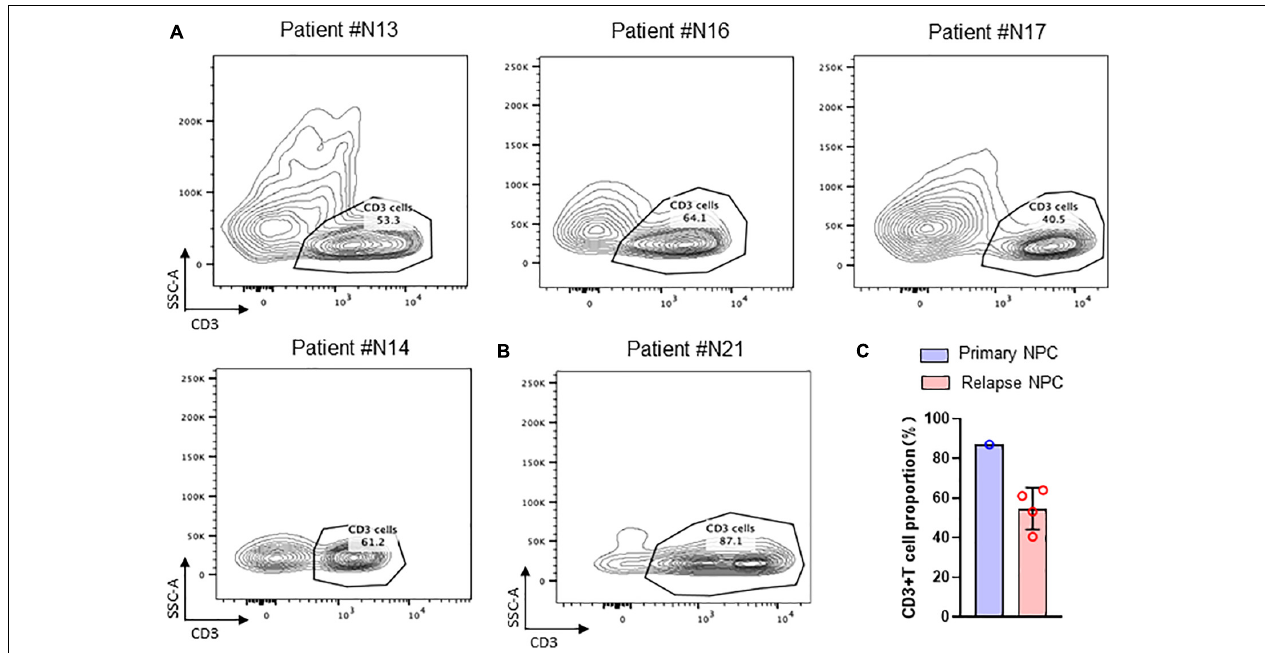
FIGURE 2 | TIL cells in NPC tissue. (A) Flow cytometry of CD3 + T cell in recurrent NPC tissue; (B) Flow cytometry of CD3 + T cell in primary NPC tissue. (C) Statistical chart of CD3 + T cell proportion.